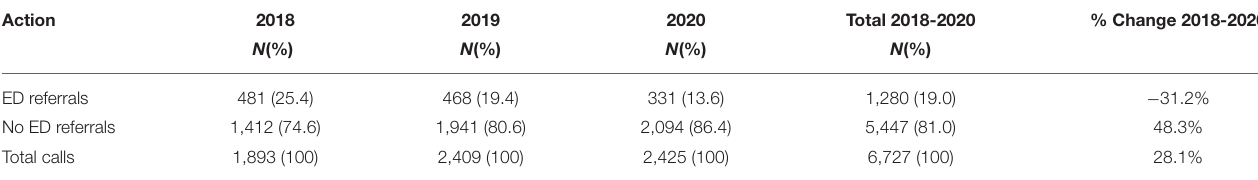
TABLE 1 | ED referrals compared to no ED referrals by year.